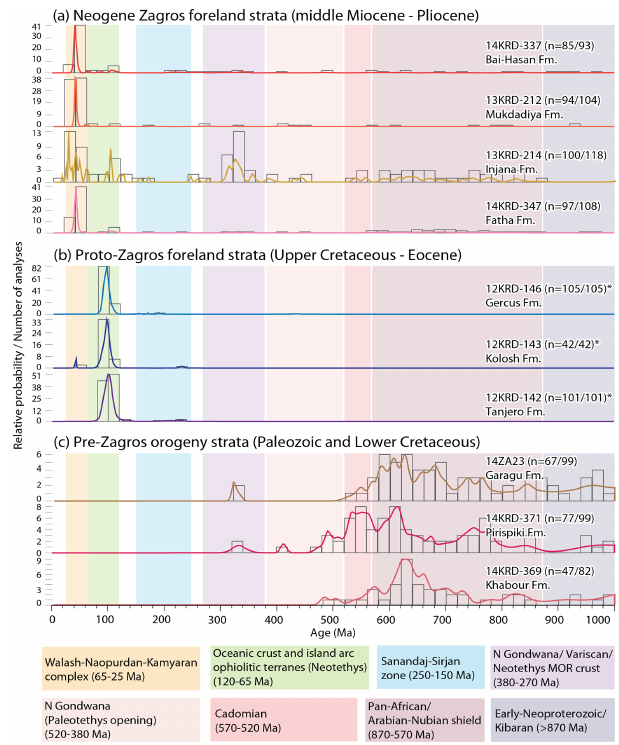
Figure 7. Detrital zircon U–Pb age distribution plots for the (a) Neogene Zagros foreland basin, (b) proto-Zagros foreland basin, and (c) pre-Zagros orogeny deposits depicted as probability density plot (PDP; bandwidth = 20, bin width = 20) and age histograms (Vermeesch, 2012). Colored shading represents the key source ter- rane age components. Samples with an asterisk are new samples. Published samples are from Koshnaw et al. (2017, 2020a). Sample locations are shown in Fig.